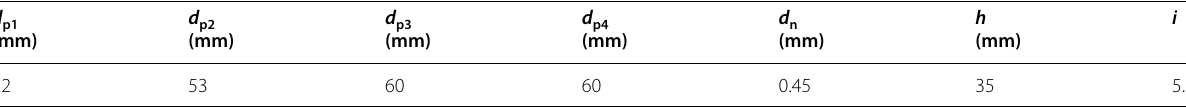
Table 1 Structural parameters of SSPWJ generation device